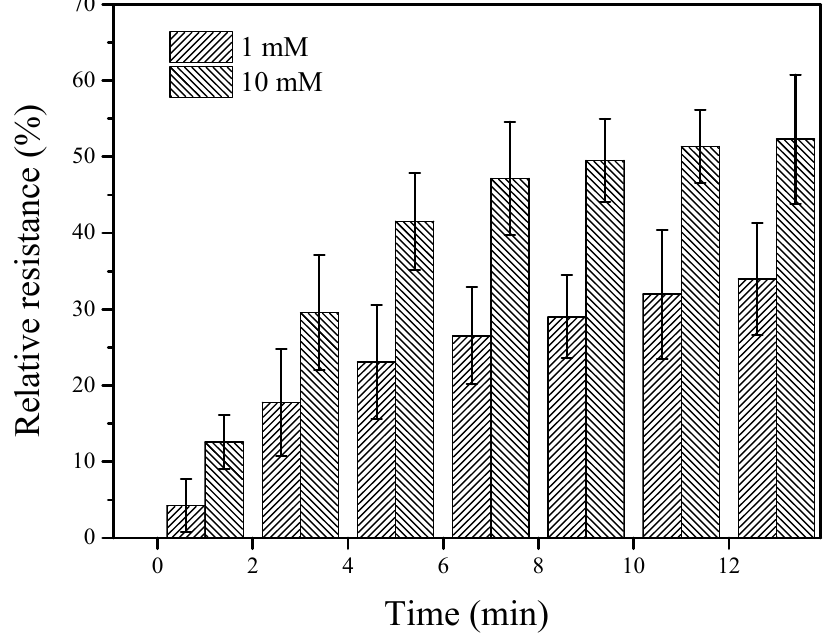
Figure 5. Relative resistance of the GCE/SWNT/DNAzyme after incubation in different Ca 2+ concentrations for different times.